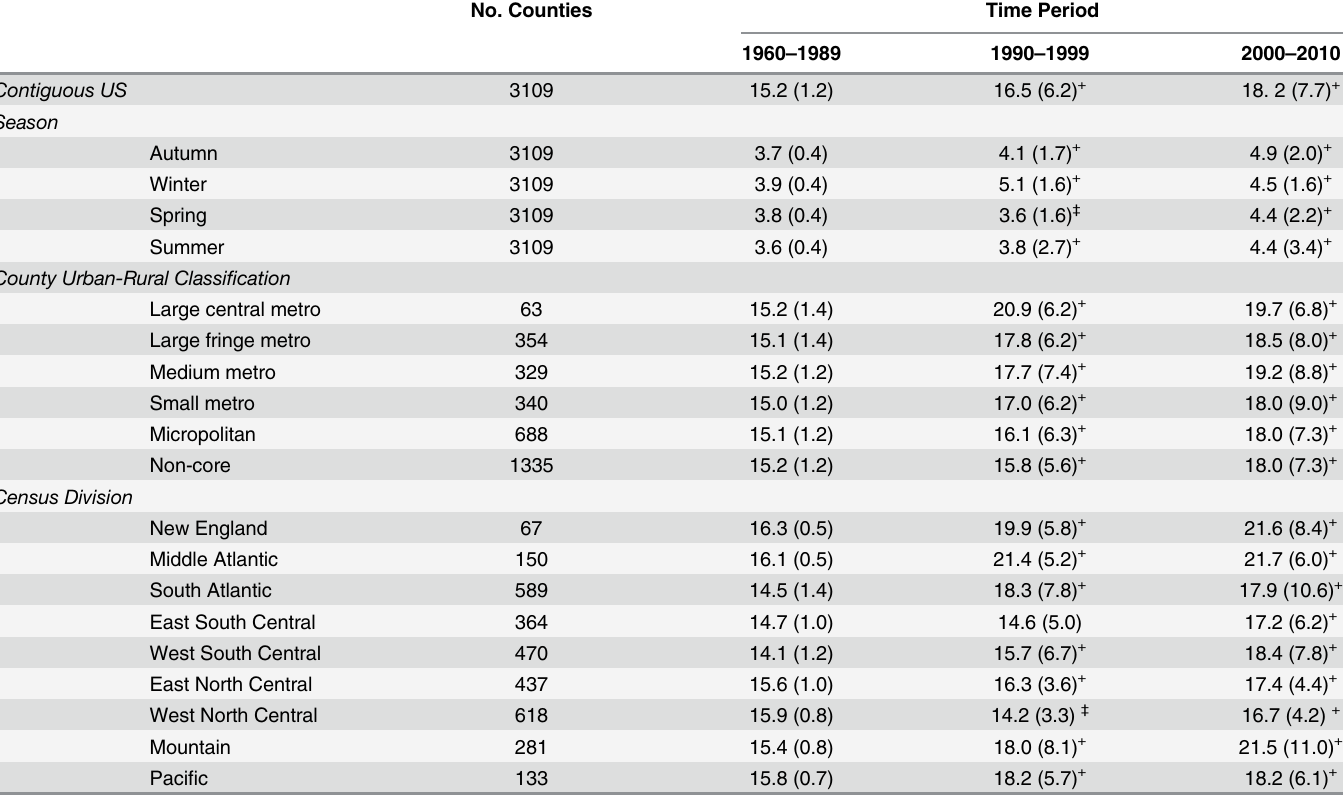
Table 1. County-level annual frequency of extreme heat events (mean (standard deviation, SD)), excluding Alaska and